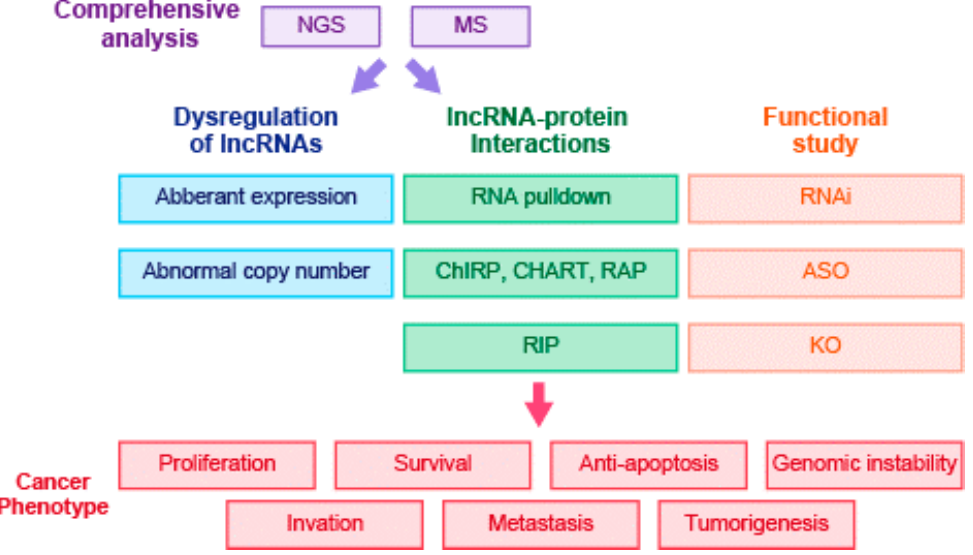
Figure 2. Identification and characterization of lncRNAs in cancer. Aberrant expression and alterations in genomic copy number in tumor cells lead the identification of lncRNAs related to cancer development. Subsequent in vitro and in vivo studies are used to elucidate the function of the identified lncRNAs in mediating distinct cancer phenotypes. RNA pulldown [40]; ChIRP, chromatin isolation by RNA purification [195]; CHART, capture hybridization analysis of RNA targets [196,197]; RAP, RNA antisense purification [198,199]; RNAi, RNA interference [9,29,39,40]; ASO, antisense oligonucleotide [40]; RIP, RNA immunoprecipitation [29,40]; KO, knockout [200–202]; NGS, next generation sequence [48,191–194]; MS, mass spectrometry [40].